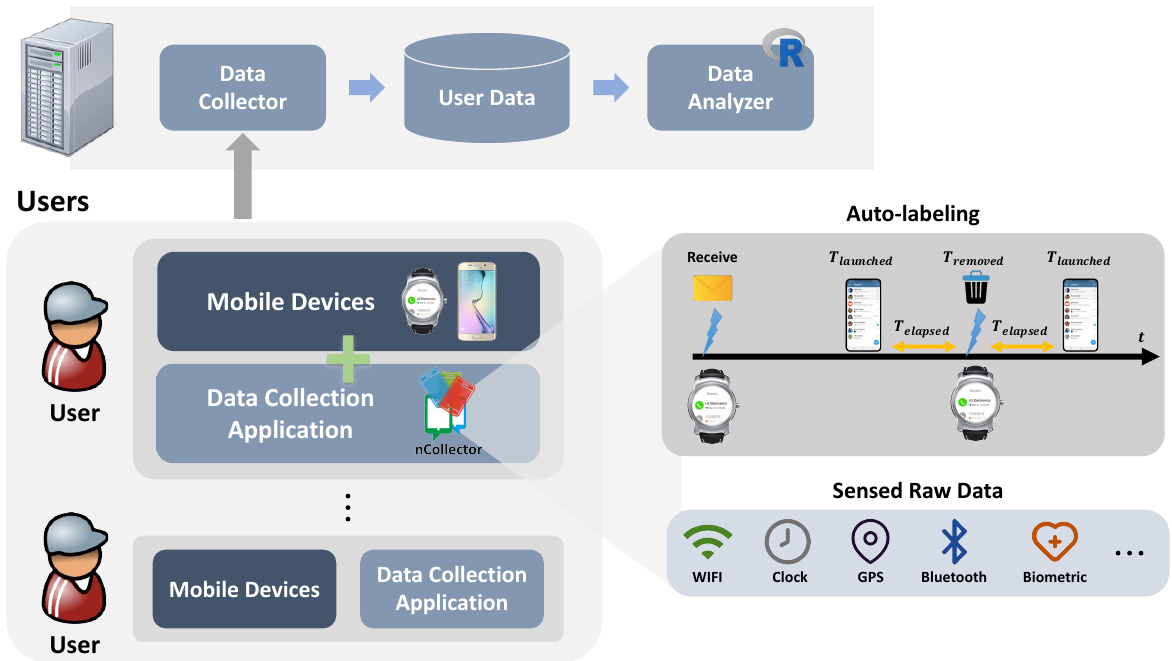
Figure 1. Overall framework for data collection and